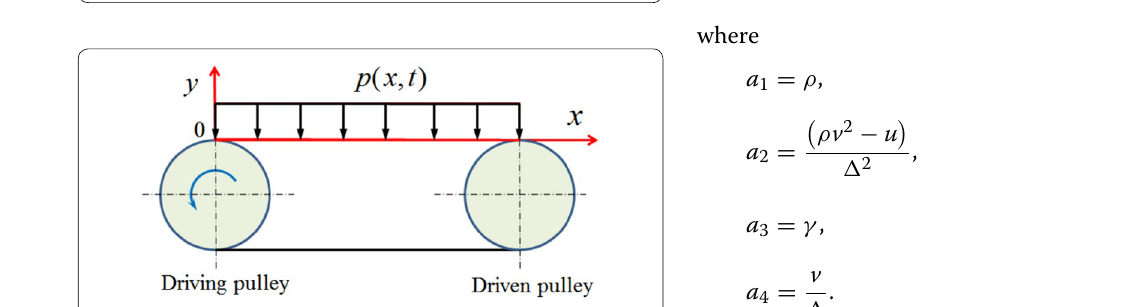
Figure 1 Schematic structure of a belt drive system